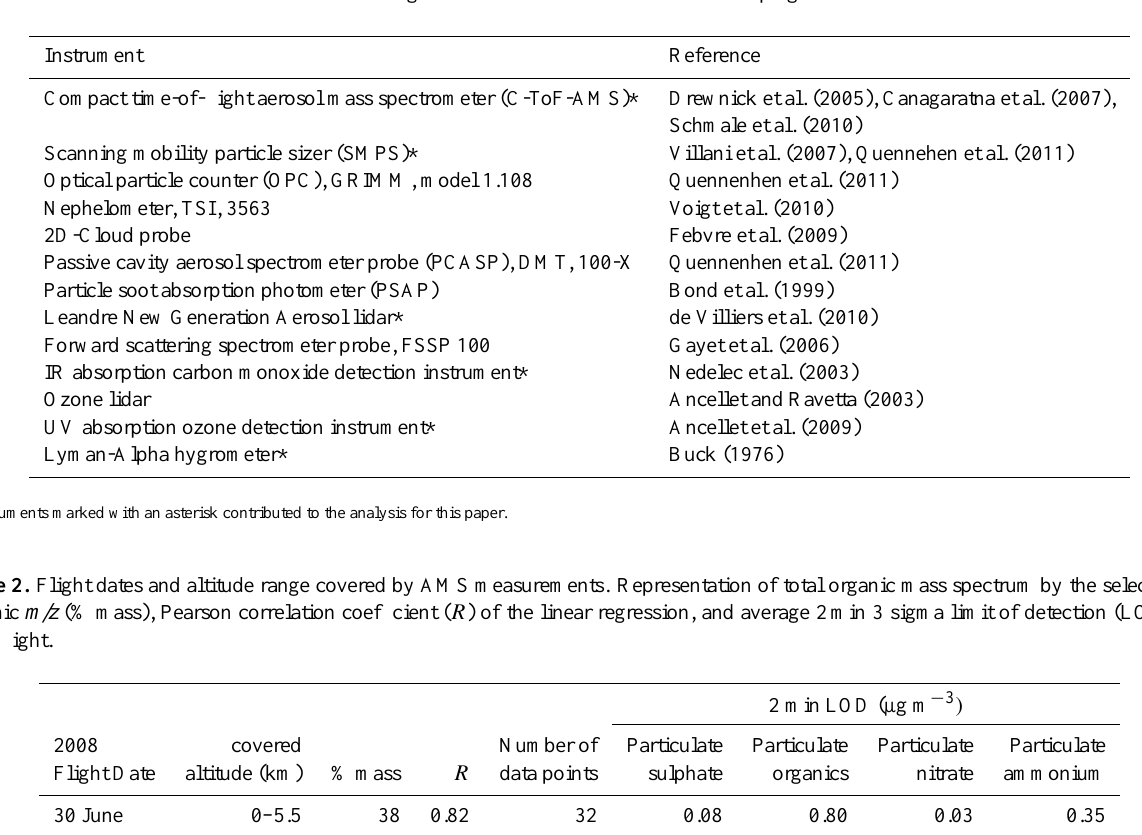
Table 1. Instrumentation aboard the ATR-42 during the POLARCAT-France summer campaign 2008.